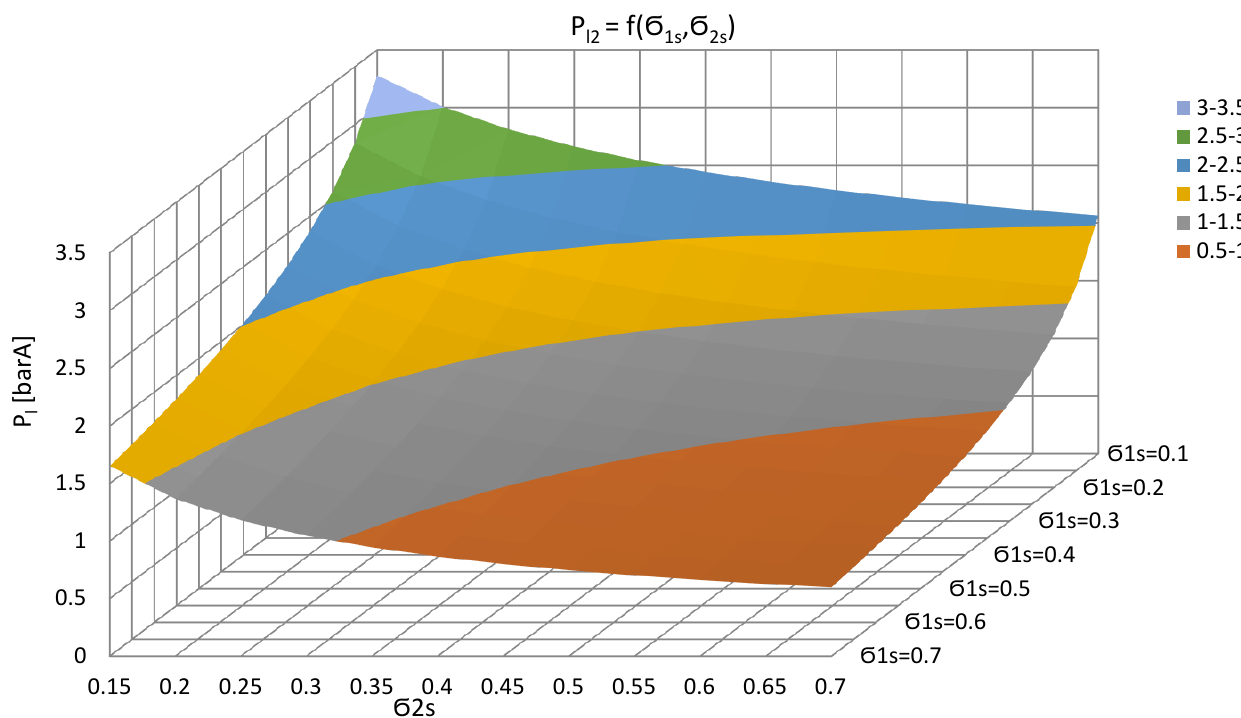
Figure 6. Relation of the steam pressure on the outlet from the two-stage injector unit driven by steam bleads 6.6 barA for both injectors in the function of the ejection ratio P l 2 = f ( σ 1 s , σ 2 s ) .